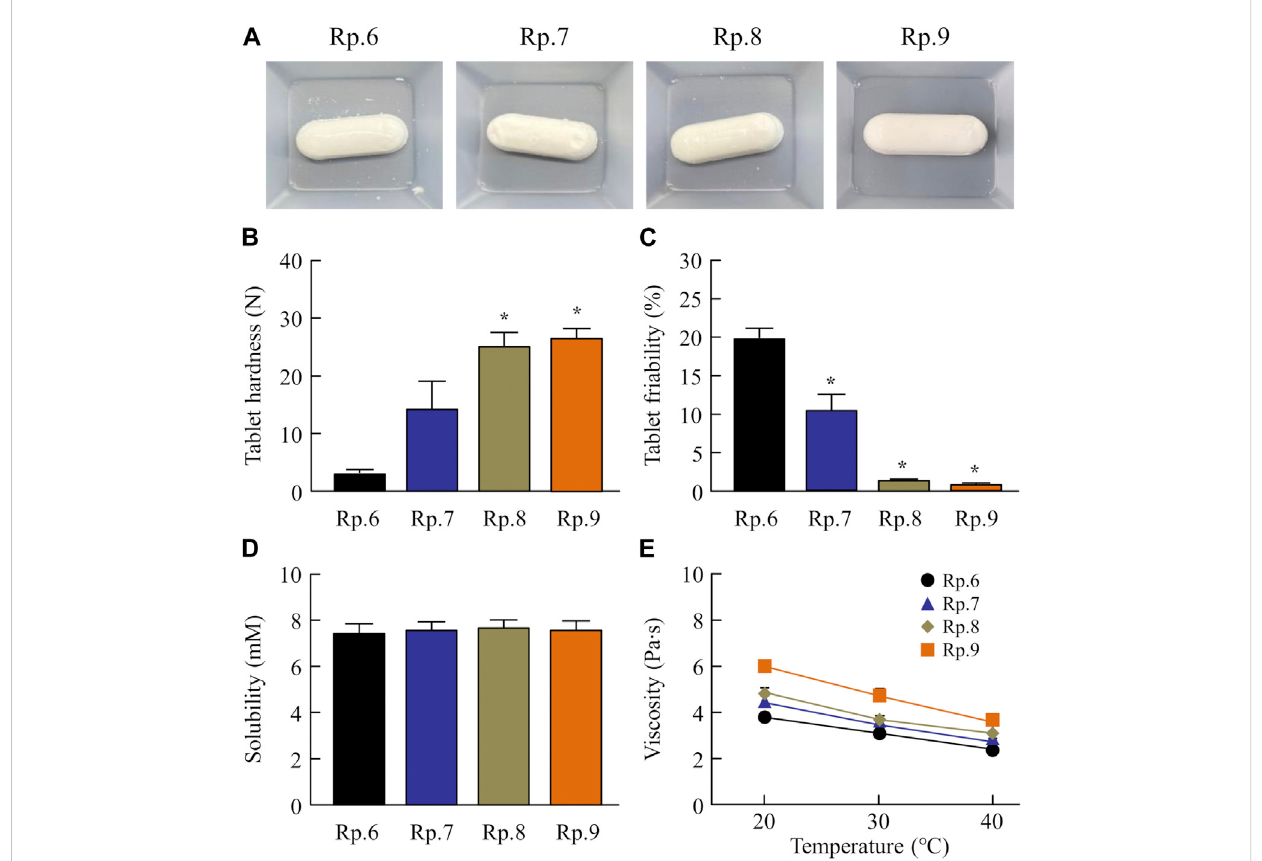
FIGURE 3 Effectofgumarabic contentsonthehardness, friability,solubility, andviscosityoftheFM-NPtabletsshown inTable1.Photograph (A) ,hardness (B) , and friability (C) of the FAM-NP tablets (Rp.6 – 9 formulations). Changes in FAM solubility (D) and viscosity (E) of redispersed FAM tablet (Rp.6 – 9 formulations) at 20 ° C – 40 ° C. n = 10. * p < 0.05 vs. Rp.6 formulations for each category. The gum arabic contents enhanced the hardness and viscosity and decreased the friability of the FAM-NP tablets. FAM solubility was similar among the Rp. 6 – Rp.9